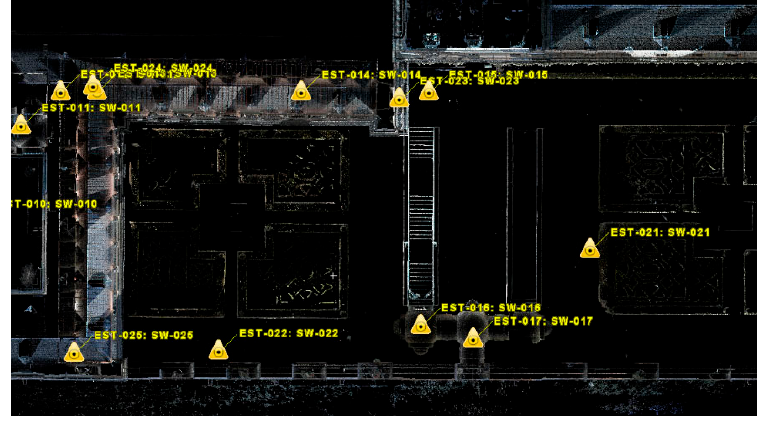
Figure 14. Station points located in the Botica and the Galería (both of them are at the height of the Jardín de los Frailes (EST-010:SW-010 to EST-015:SW-015)), points on the Jardín (EST-021:SW-021 and EST-022:SW-022), and another at the level of the ground floor of the Monastery (EST-023:SW-023 to EST-025:SW-025). Station points defined with numbers lower than EST-010:SW-010, correspond to locations outside the complex to the north and west sides, while those between EST-016:SW-016 and EST-020:SW-020 correspond to positions at the height of the sidewalk at the foot of the Muro de los Nichos .